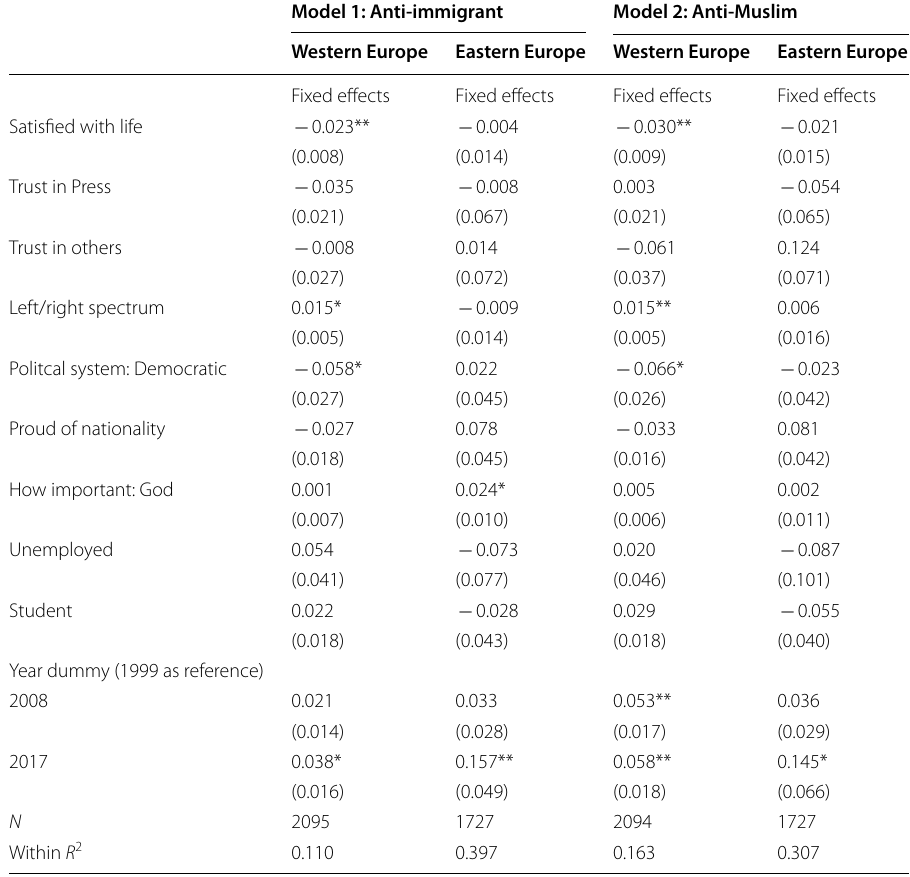
Table 1 Pseudo-panel analysis of anti-immigrant and anti-Muslim attitudes in Western and Eastern